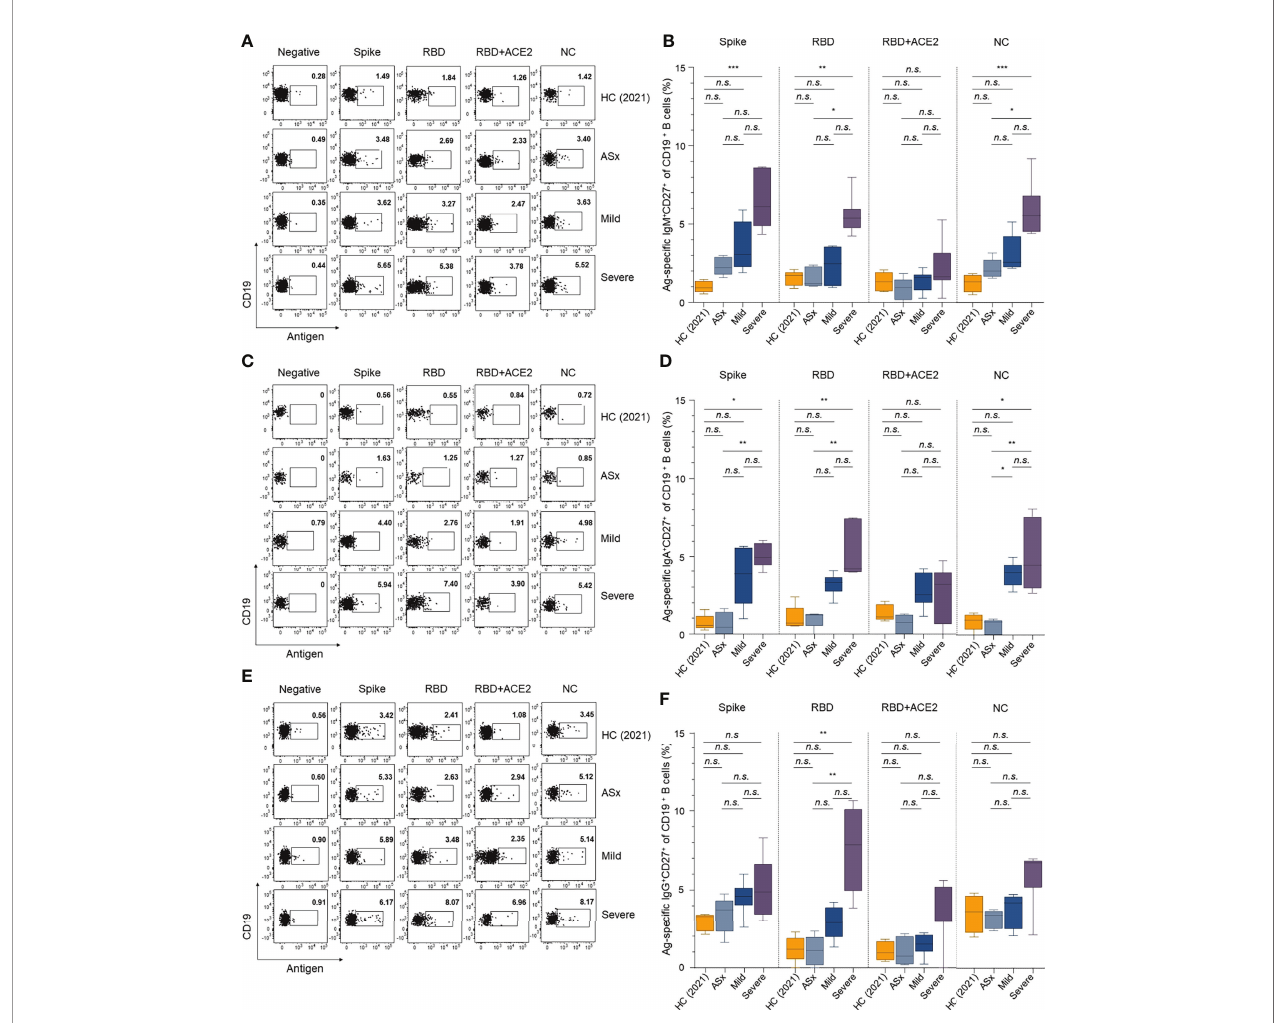
FIGURE 3 | Memory B-cell responses against SARS-CoV-2 according to the severity of illness. (A, C, E) Representative gating strategy for IgM+, IgA+, and IgG+ antigen-speci fi c memory (CD27+ CD19+) B cells. (B, D, F) Frequencies of IgM+, IgA+, and IgG+ antigen-speci fi c memory B cells according to the severity of illness and different antigens. Statistical analysis was performed using the Kruskal – Wallis rank-sum test with Dunn ’ s post hoc test in GraphPad Prism (n.s.: P > 0.05, *P < 0.05, **P < 0.01, ***P <